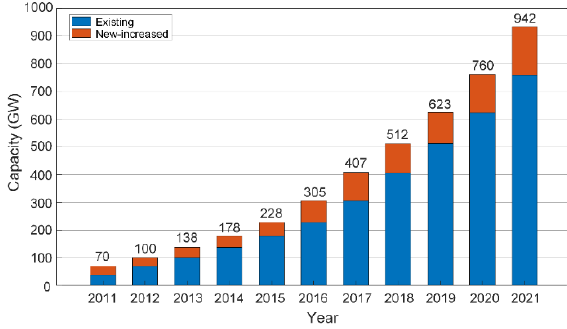
Figure 1. Global PV capacity and annual additions.